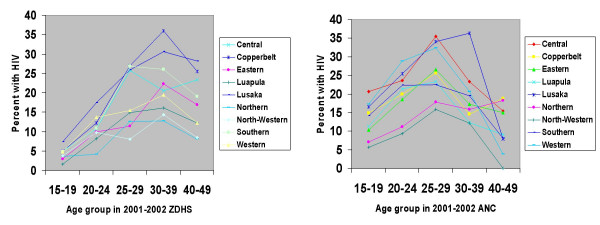
2001–2002 ANC and ZDHS HIV prevalence estimates by age group and province.